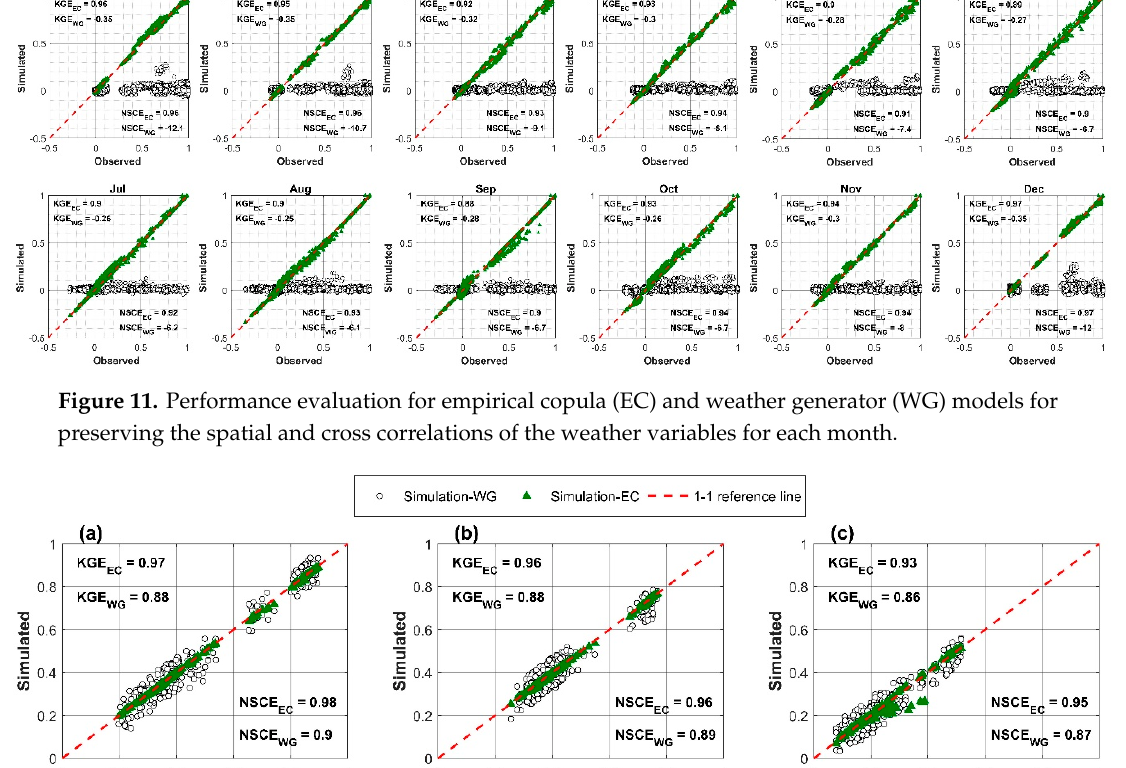
Figure 12. Monthly performance evaluation for EC and WG models for preserving the temporal correlation (Lag-1 day) of the weather